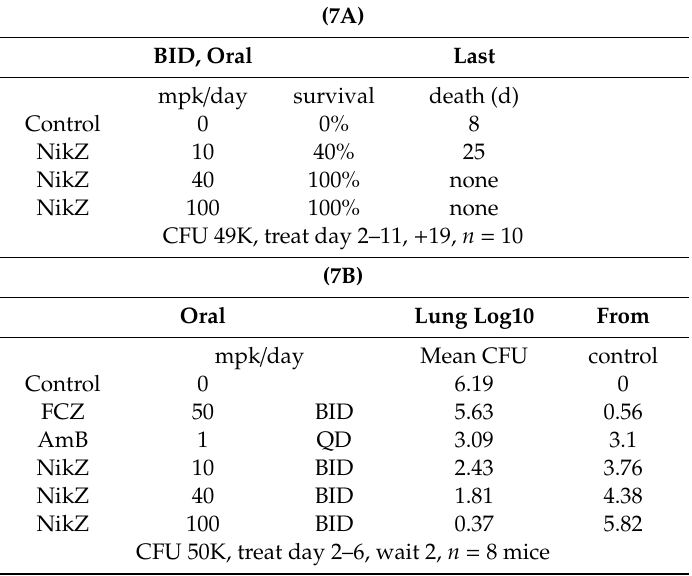
Table 7. A, B: IV disseminated blastomycosis ( 7A ) survival, ( 7B ) organ burden